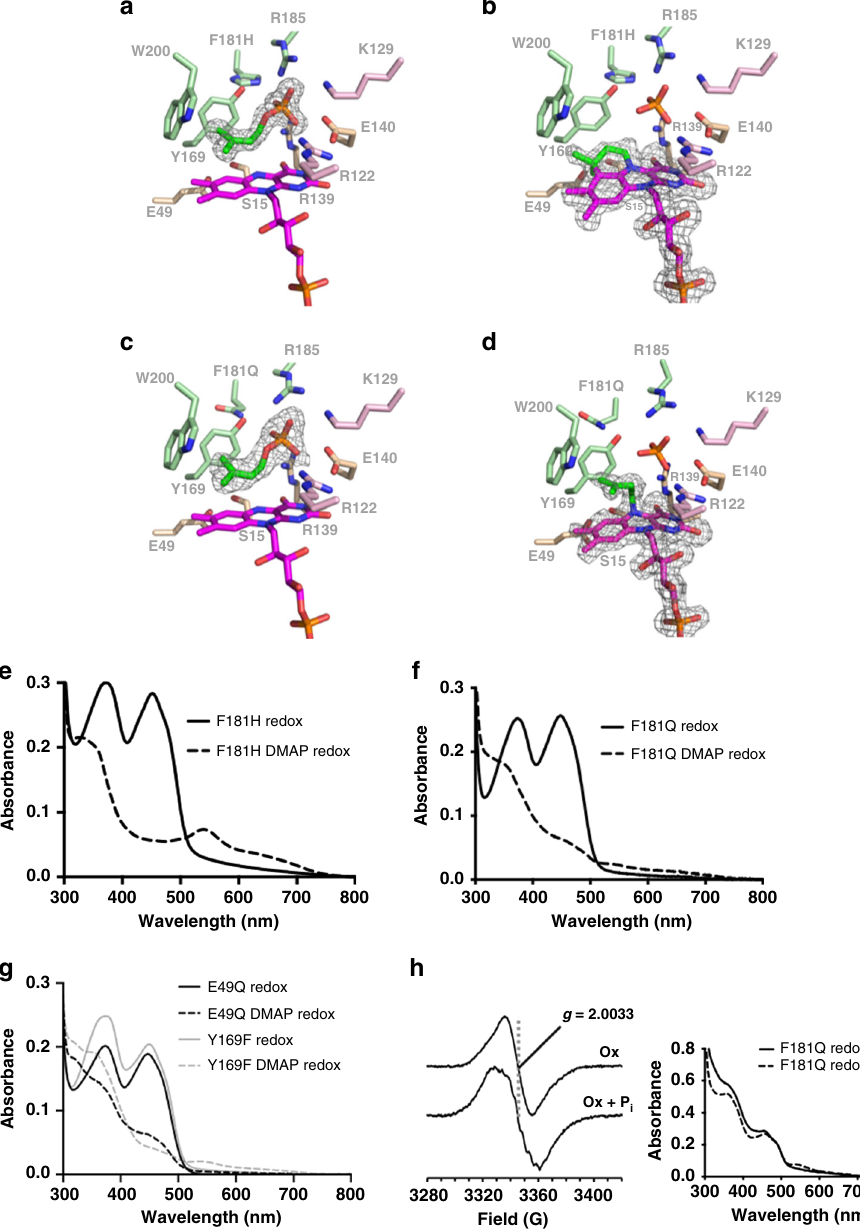
Fig. 4 Phosphate retention is key to C6 – C3 ’ bond formation in Pa UbiX. a The crystal structure of the F181H Pa UbiX variant in complex with DMAP